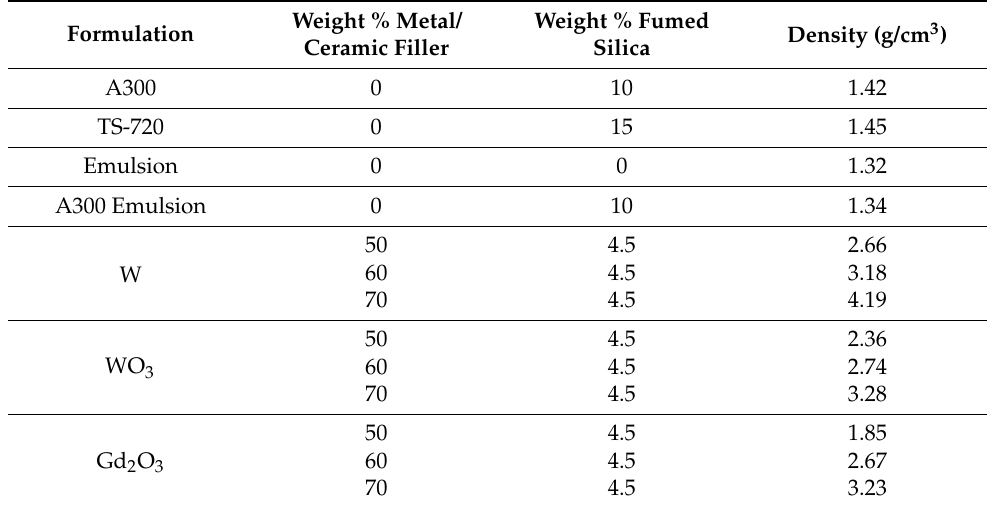
Table 1. Weight percent fillers and densities for ink formulations used in this